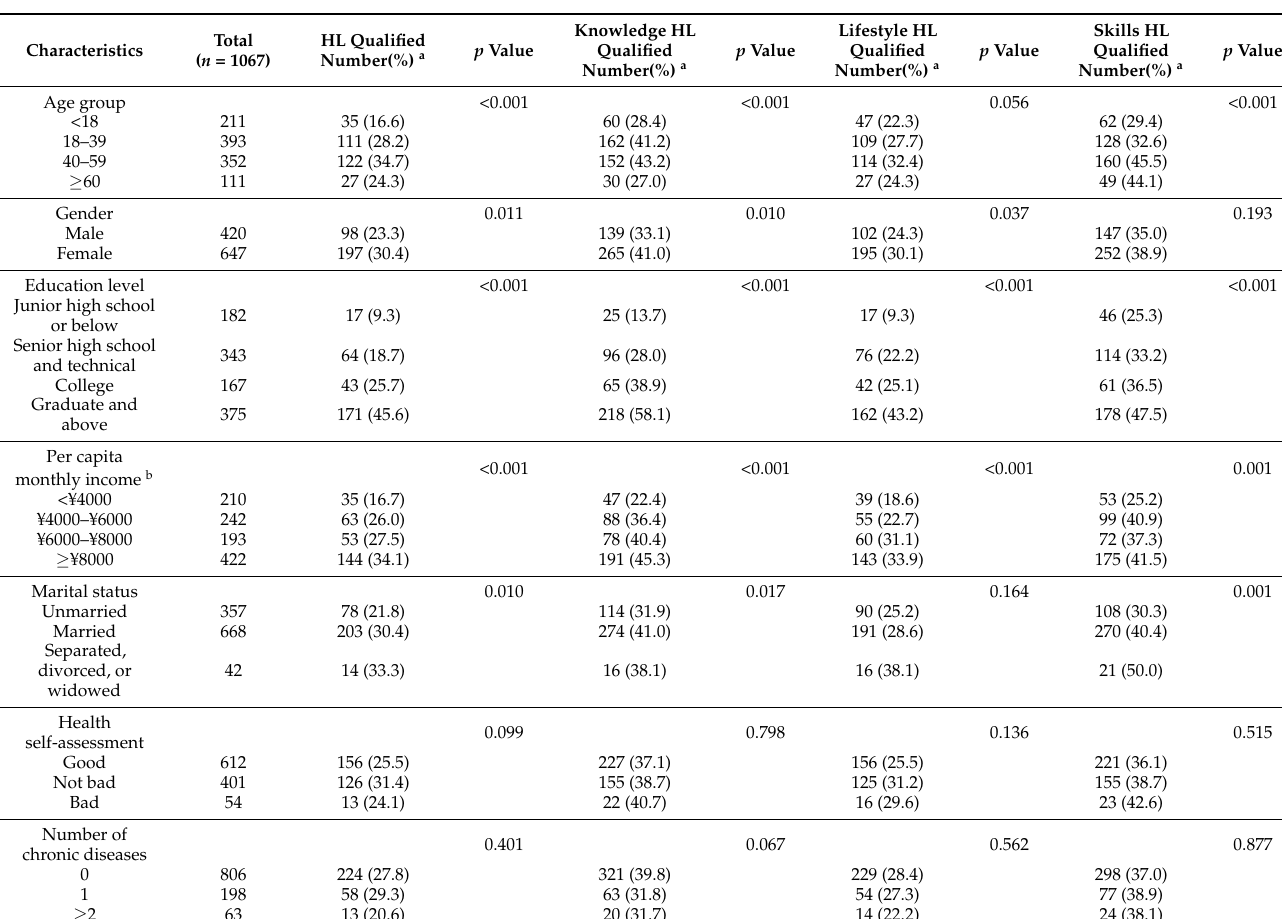
Table 1. General characteristics of participants qualified in health literacy, knowledge HL, lifestyle HL, and skills HL.